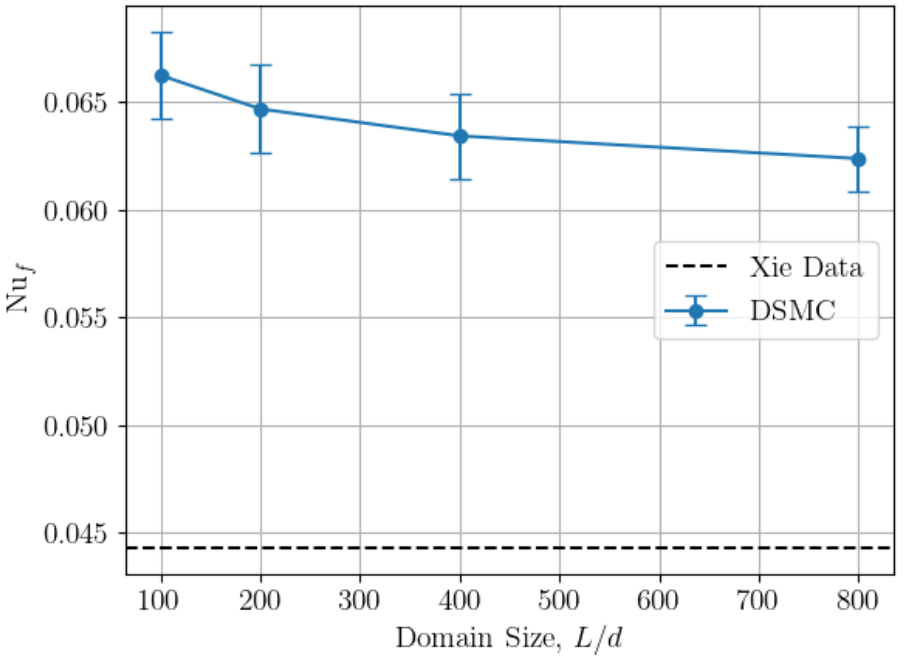
Figure 10. Simulated wire heat transfer dependence on domain size for the Kn f = 3.74, Re f = 0.0032 case. Error bars indicate ± 1 σ of the steady-state DSMC data. The experimental value from Xie et al. [6] for Kn f = 3.68, Re f = 0.0038 is also